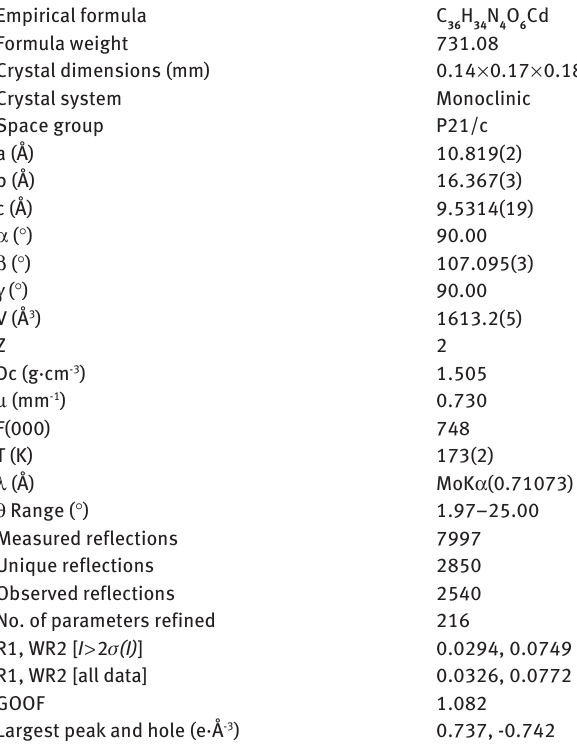
Table 4: Crystal data and refinement